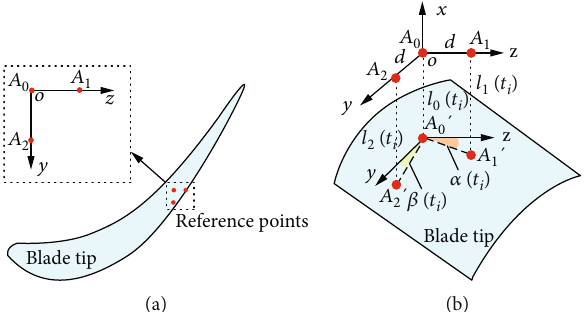
Figure 3: Schematic of the computation of 3D-BTC. (a) Reference points. (b) Schematic of the 3D-BTC computation.